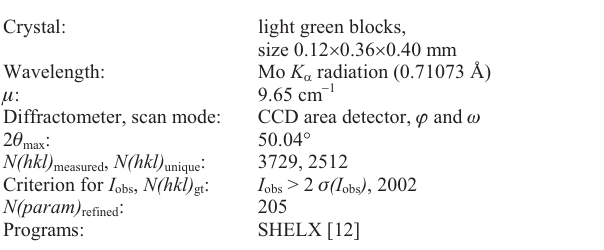
Table 1. Data collection and